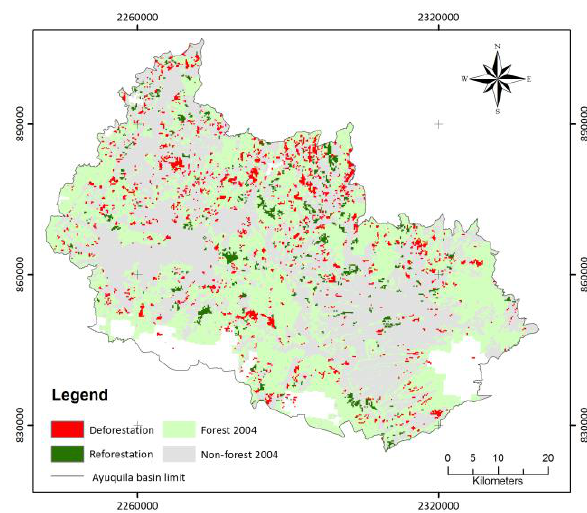
Figure 2. Forest change patches by visual interpretation of SPOT-5 images (2004-2010) and presented with the land cover map 2004 as the background.